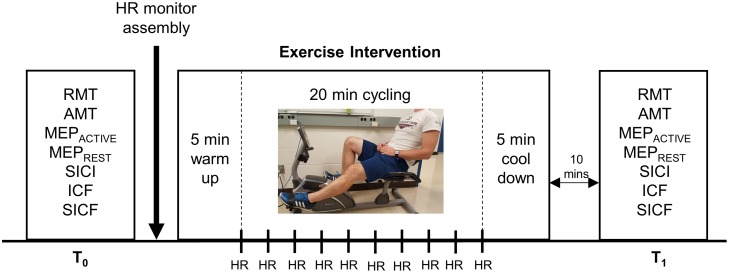
Experimental timeline.Measures of resting motor threshold (RMT), active motor threshold (AMT), motor evoked potential (MEP) recruitment curves obtained at rest (MEPREST) and during ~10% MVC (MEPACTIVE), short-interval intracortical inhibition (SICI), intracortical facilitation (ICF) and short-interval intracortical facilitation (SICF) were acquired prior to (T0) and ten minutes following the cessation of exercise (T1).The order of dependent measure acquisition was pseudo-randomized across participants using a Williams Square design. The exercise intervention began following the assembly of the heart rate (HR) monitor and involved 5 minutes of cycling warm-up, 20 minutes of moderate-intensity exercise (50–70% of age-predicted maximal heart rate (HR)) and 5 minutes of cycling cool-down. During the 20-minute exercise, resistance was adjusted online to maintain HR in the target range. HR was recorded every 2 minutes as shown.